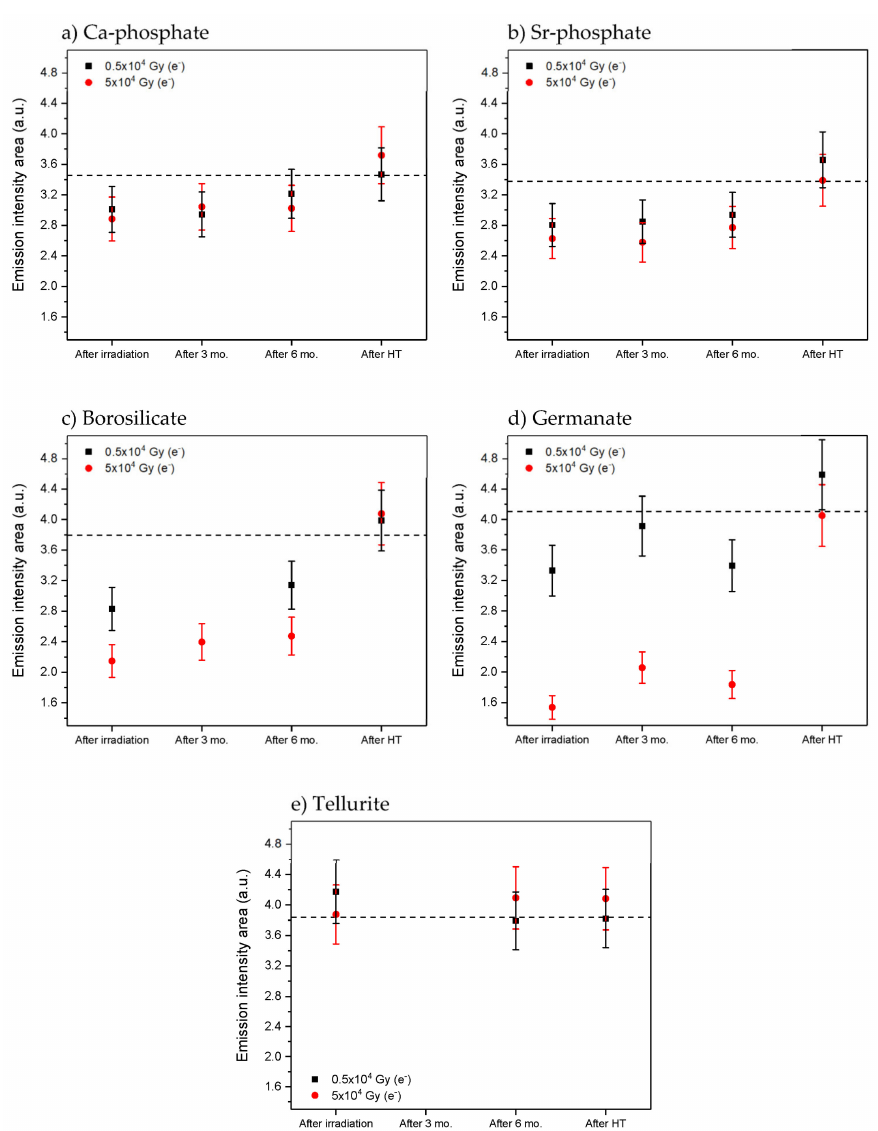
Figure 7. Yb 3+ emission intensity area ( λ ex. = 963 nm) measured after irradiation, 3 and 6 months after irradiation and also after heat treatment (HT) at T g for 15 min of Ca-phosphate ( a ), Sr-phosphate ( b ), borosilicate ( c ), germanate ( d ) and tellurite ( e ) glasses, respectively. Dashed line shows emission intensity area for as-prepared sample, error bars ±